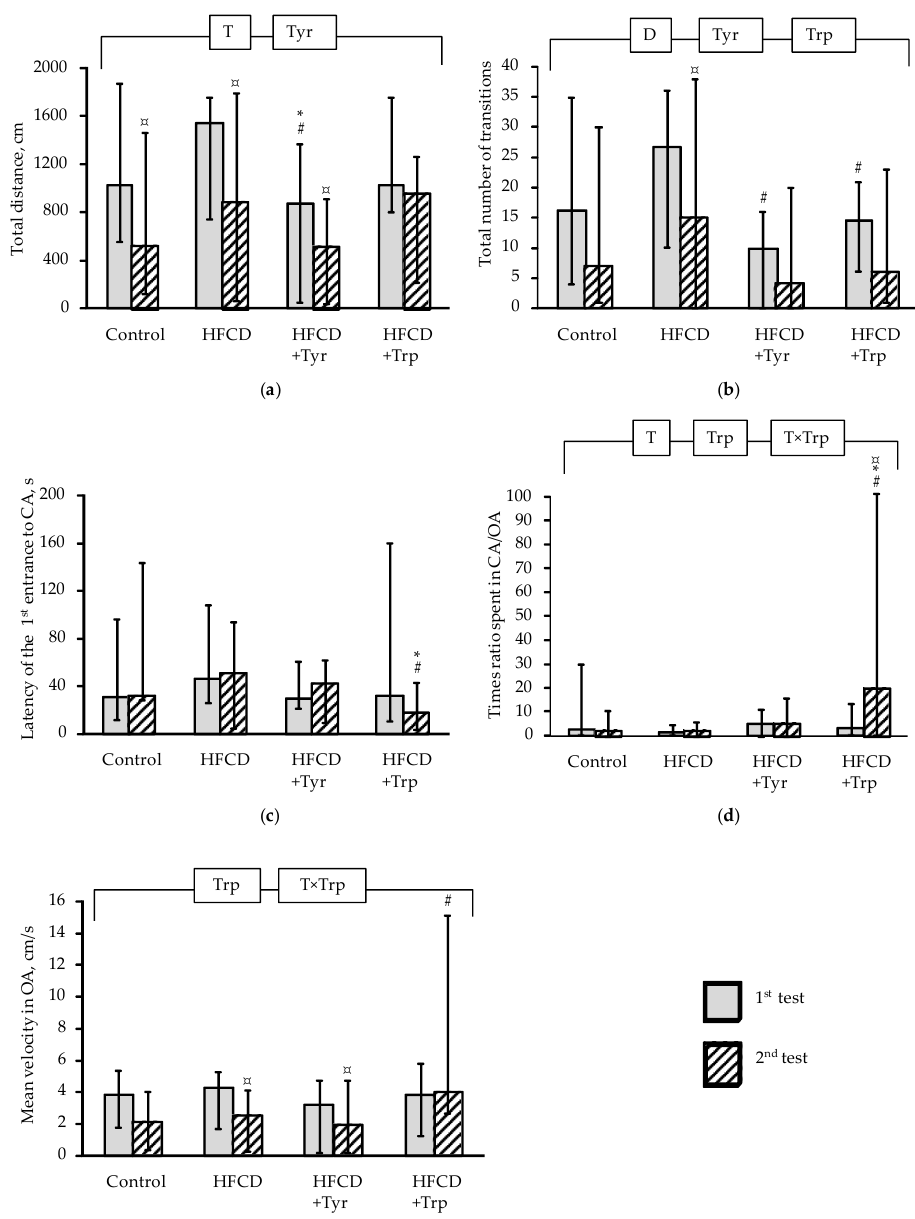
Figure 4. Indicators of rats tested in the EPM, (median, intervals of change): total distance traveled ( a ), total number of transitions ( b ); latency of the first entry into the closed arm ( c ); the ratio of the time spent in the closed (CA) and open (OA) arms of the maze ( d ), the average speed in the OA ( e ). * the difference with the control group is significant; # the difference with the group receiving HFCD is significant, p < 0.05, Mann-Whitney test; ¤ the difference with the first test is significant, the Wilcoxon test for pairwise comparisons. The bracket above the bars denotes significant dependence on the factors: “test” (T), “diet” (D), “tyrosine” (Tyr), “tryptophan” (Trp) and their combinations, p < 0.05, 3-way ANOVA. The number of animals in the groups was 8.